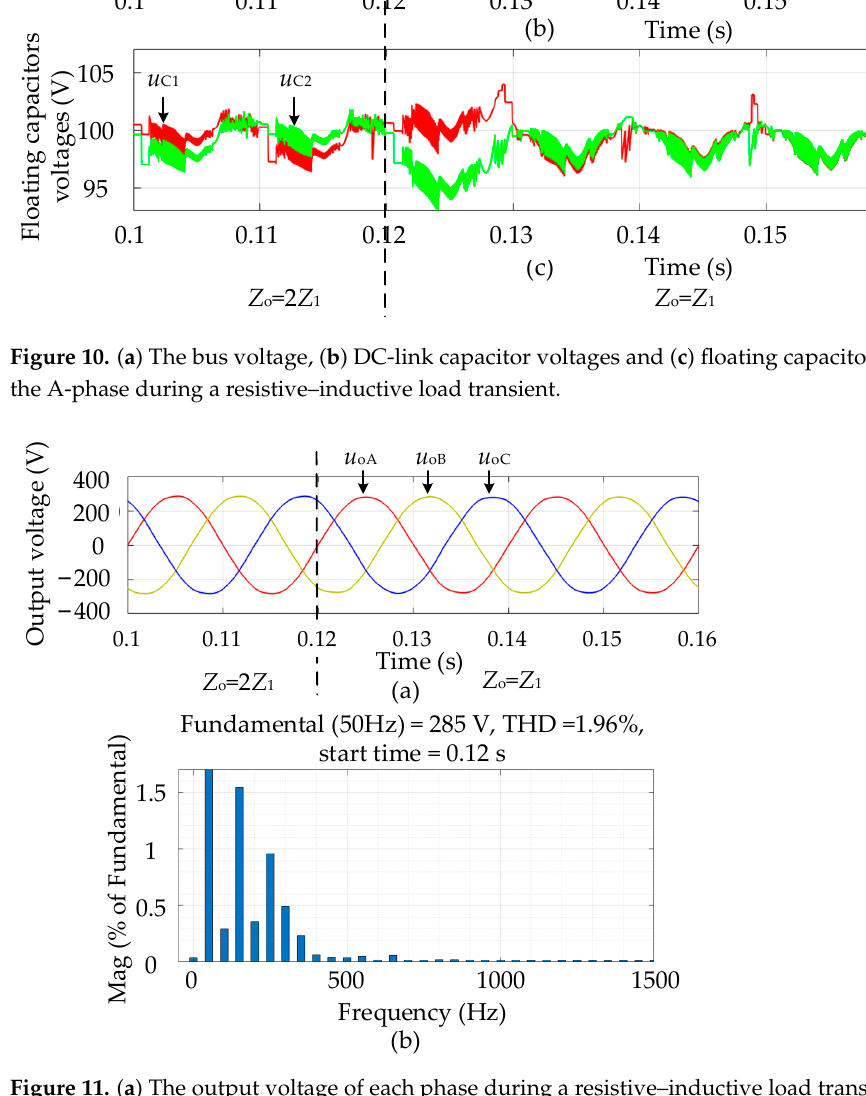
Figure 11. ( a ) The output voltage of each phase during a resistive–inductive load transient. ( b ) The FFT result of the A-phase output voltage.